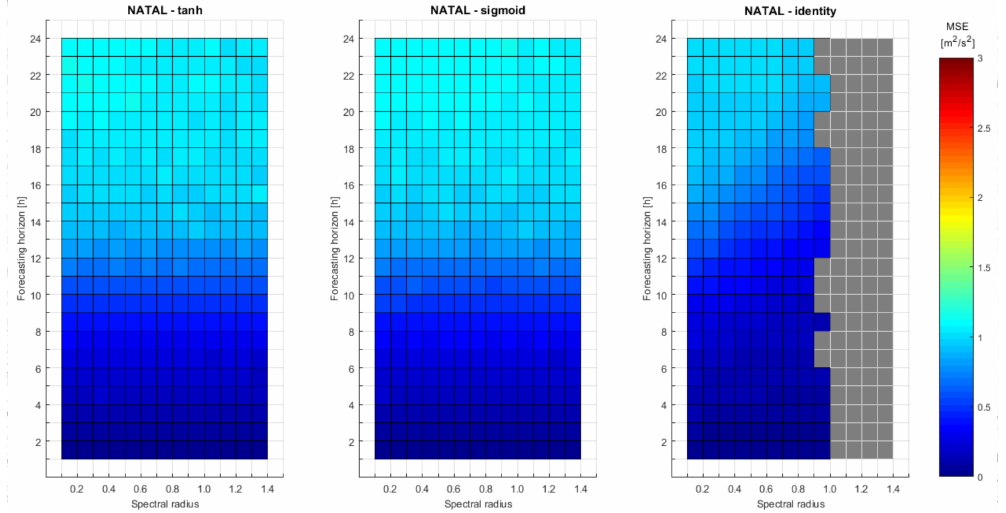
Figure 12. MSE for all tested ESN—Natal. From left to right: Hyperbolic tangent, Logistic sigmoid and